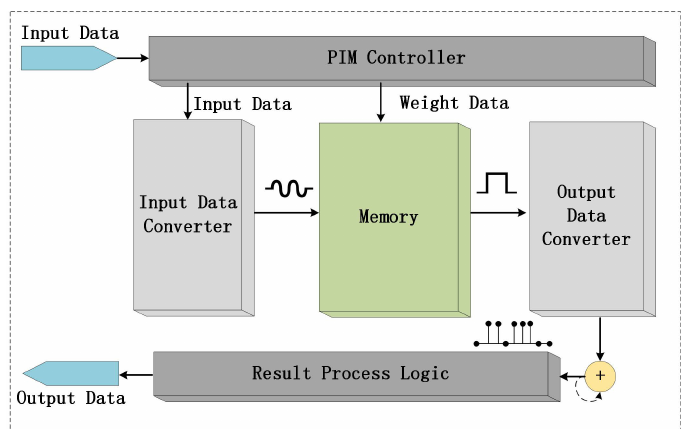
Figure 1. Schematic illustration of a conventional PIM configuration.